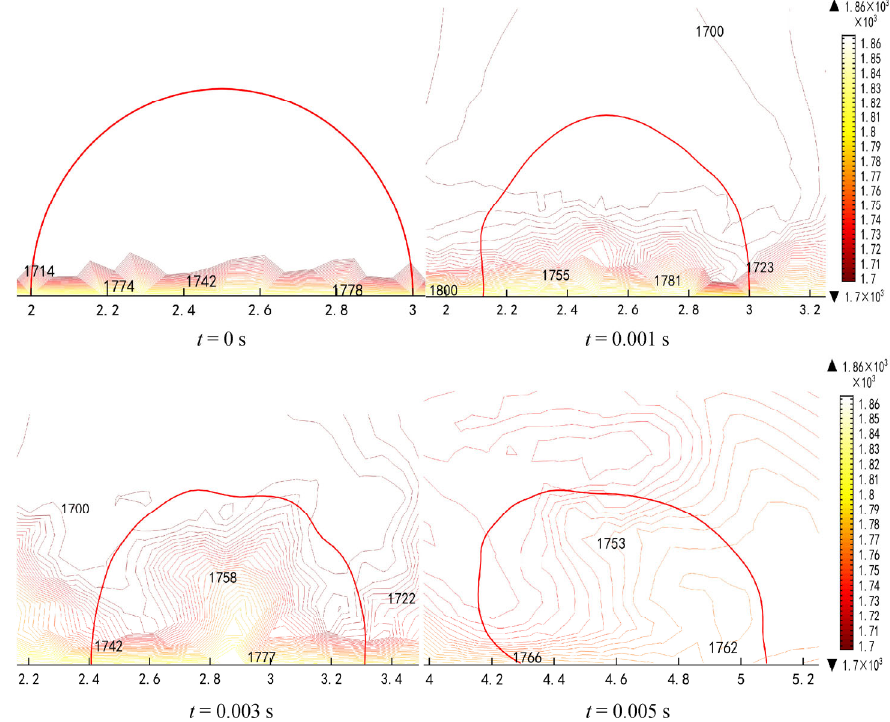
Fig. 14 Variation of T field of molten silicon droplet on corundum ( θ = 90°) substrate during motion process.